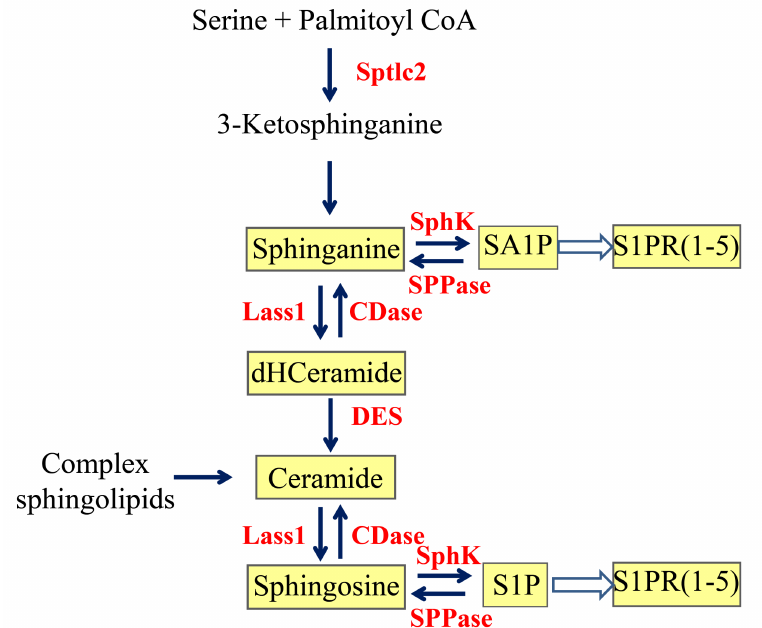
Figure 1. Formation of bioactive sphingosine-1-phosphate (S1P) and sphinganine-1-phosphate (SA1P) in mammalian cells. Sptcl2: serine palmitoyltransferase long chain base subunit 2; Lass1: longevity assurance gene 1; CDase: ceramidase; DES: desaturase; SphK: sphingosine / sphinganine kinase; SPPase: sphingosine / sphinganine-1-phosphate phosphatase; S1PR: sphingosine / sphinganine-1-phosphate receptor; dHCeramide: